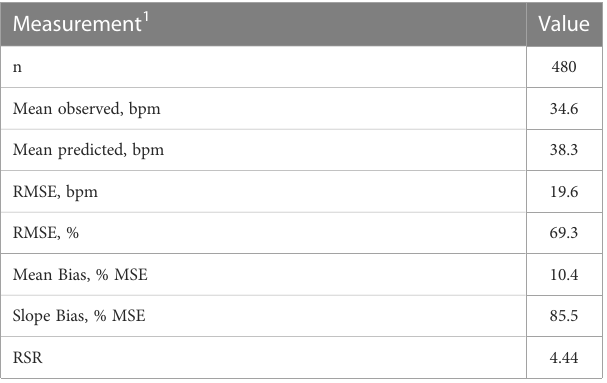
1 n, number of observations; bpm, beats per minute; RMSE, root mean squared error of PPG measurements versus ground truth observations (higher values are undesirable); MSE, mean squared error of PPG measurements versus ground truth observations; and RSR, RMSE- observations standard deviation ratio (values > 1 are